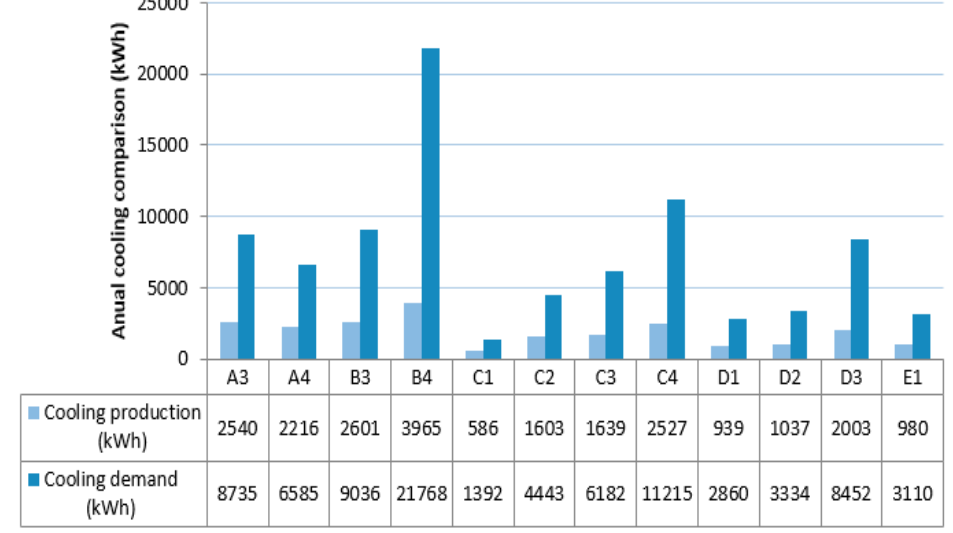
Figure 11. Annual cooling comparison for the different climatic zones.